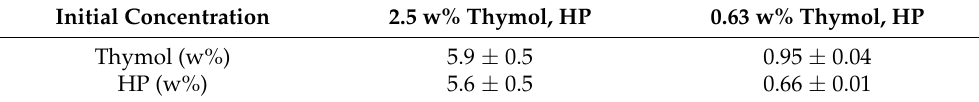
Table 1. HP and thymol initial contents (precursor solutions) in combined